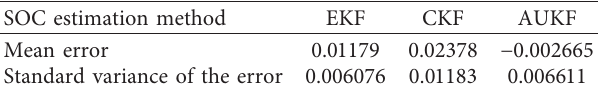
Figure 14: (a) SOC estimation results based on AUKF, EKF, and CKF; (b) errors of AUKF, EKF, and CKF in estimating SOC. Table 1: Summary statistics of the SOC estimation result of the three Kalman filter methods.